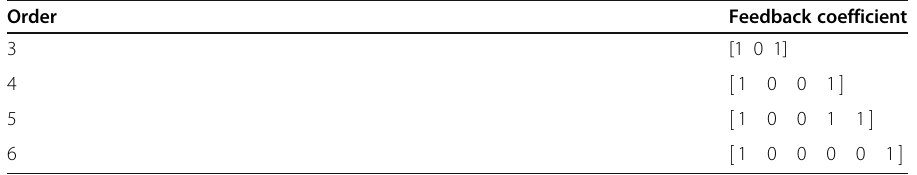
Table 2 Different order feedback coefficients of m-sequence. The m-sequence feedback coefficients of different orders selected for simulation